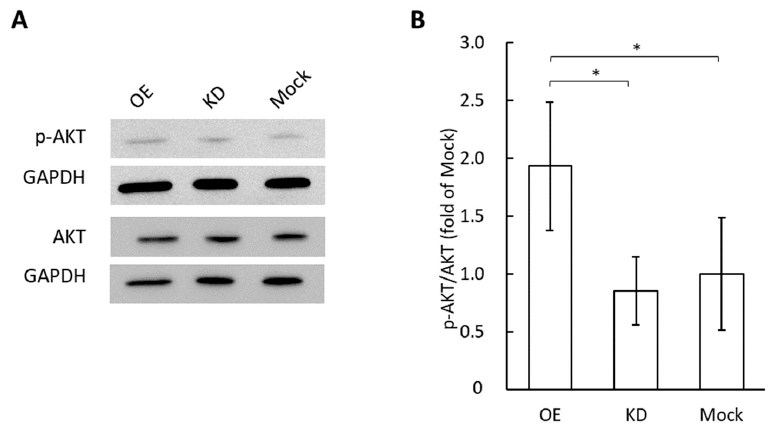
Figure 3. Phosphorylation of AKT in vascular endothelial cells after the treatment of exosomes containing various concentrations of GRP78 for 48 h. ( A ) Western blotting for phosphorylated and non-phosphorylated AKT. GAPDH was used as the control. ( B ) Comparison of the Ser473 phosphorylation state ratio of AKT estimated from the band density; n = 5 each; * p < 0.05.